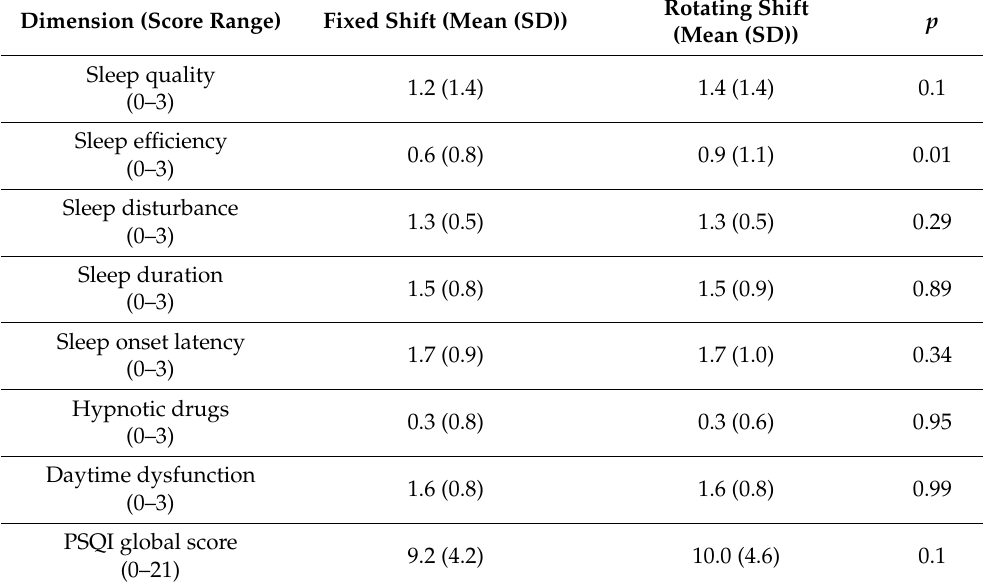
Table 5. PSQI scores.